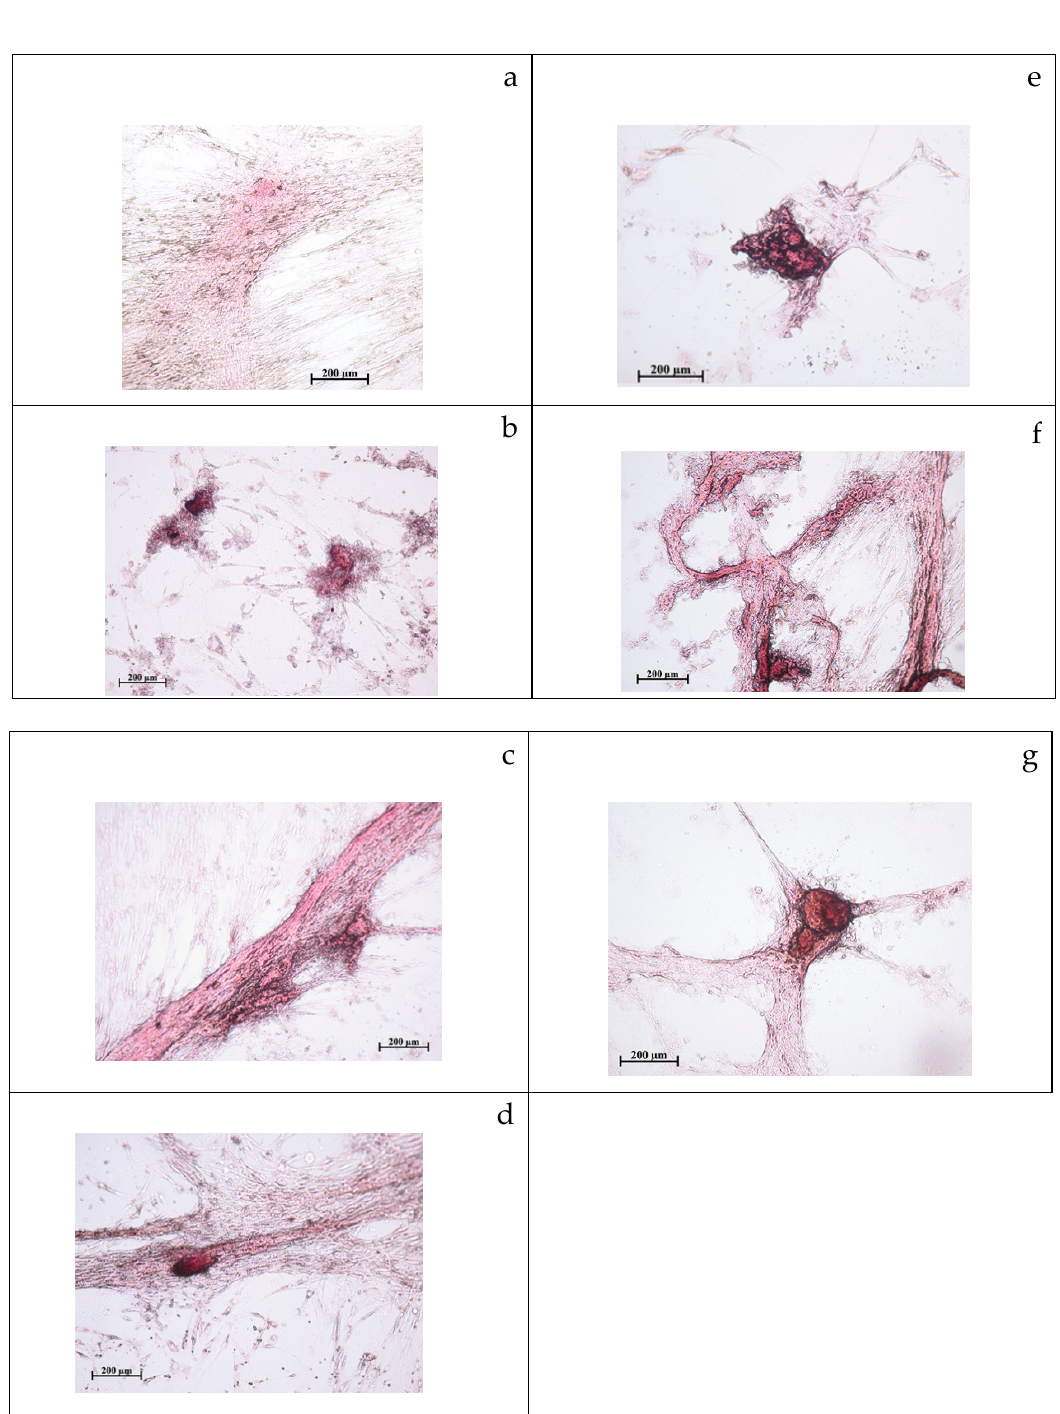
4 of 15 Table 2. In vitro effect of tested compounds on hAMMSC osteogenic differentiation with mineralization of cell culture matrix, X ± SD, Me (Q1–Q3). Group, n = 3